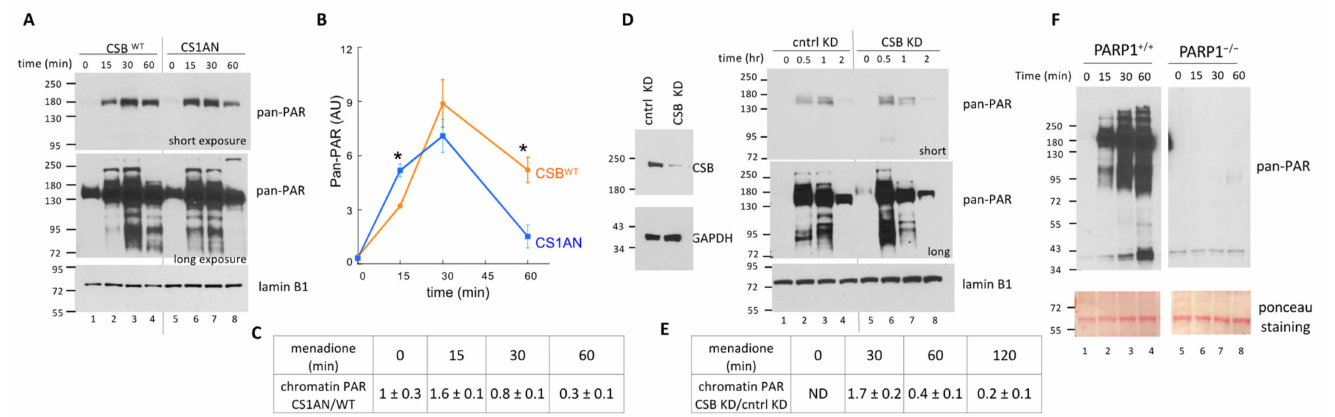
Figure 4. CSB regulates PAR levels on oxidatively damaged chromatin. ( A ) Chromatin-enriched fractions were isolated from CSB WT and CS1AN cells at the indicated time points during a 100 µ M menadione treatment. Equal amounts of chromatin-associated proteins at each time point were resolved by SDS-PAGE and PARylated proteins were identified with the pan-PAR binding reagent. Lamin B1 was used as a loading control. ( B ) Quantification of data from Western blots obtained from three biological replicates. Paired t -tests were used to compare PAR levels in CSB WT vs. CS1AN cells; *: p < 0.05. ( C ) Ratios of PAR levels in CS1AN vs. CSB WT . Shown are means +/ − SEM ( n = 3 biological replicates). ( D , E ) Same as A and C, except that PARP1 +/+ RPE cells expressing CSB-targeting shRNA were compared to cells expressing a control shRNA ( n = 2 biological replicates). The extent of CSB knockdown is shown in the left panel. ( F ) Same as D, but PARP1 +/+ and PARP1 − / − cells were